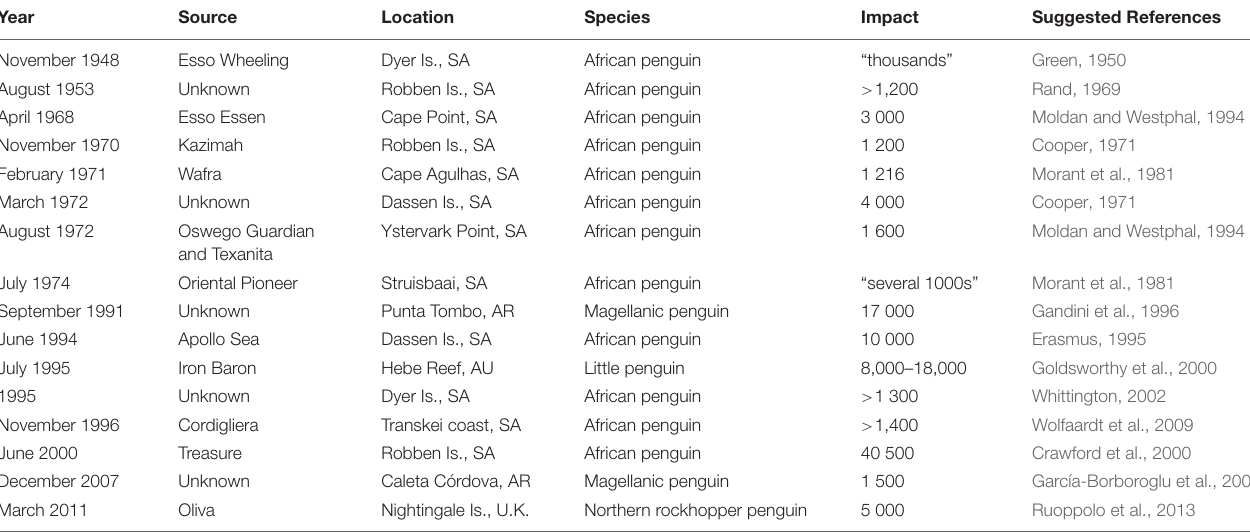
TABLE 2 | Oil spills affecting penguin colonies between 1948 and